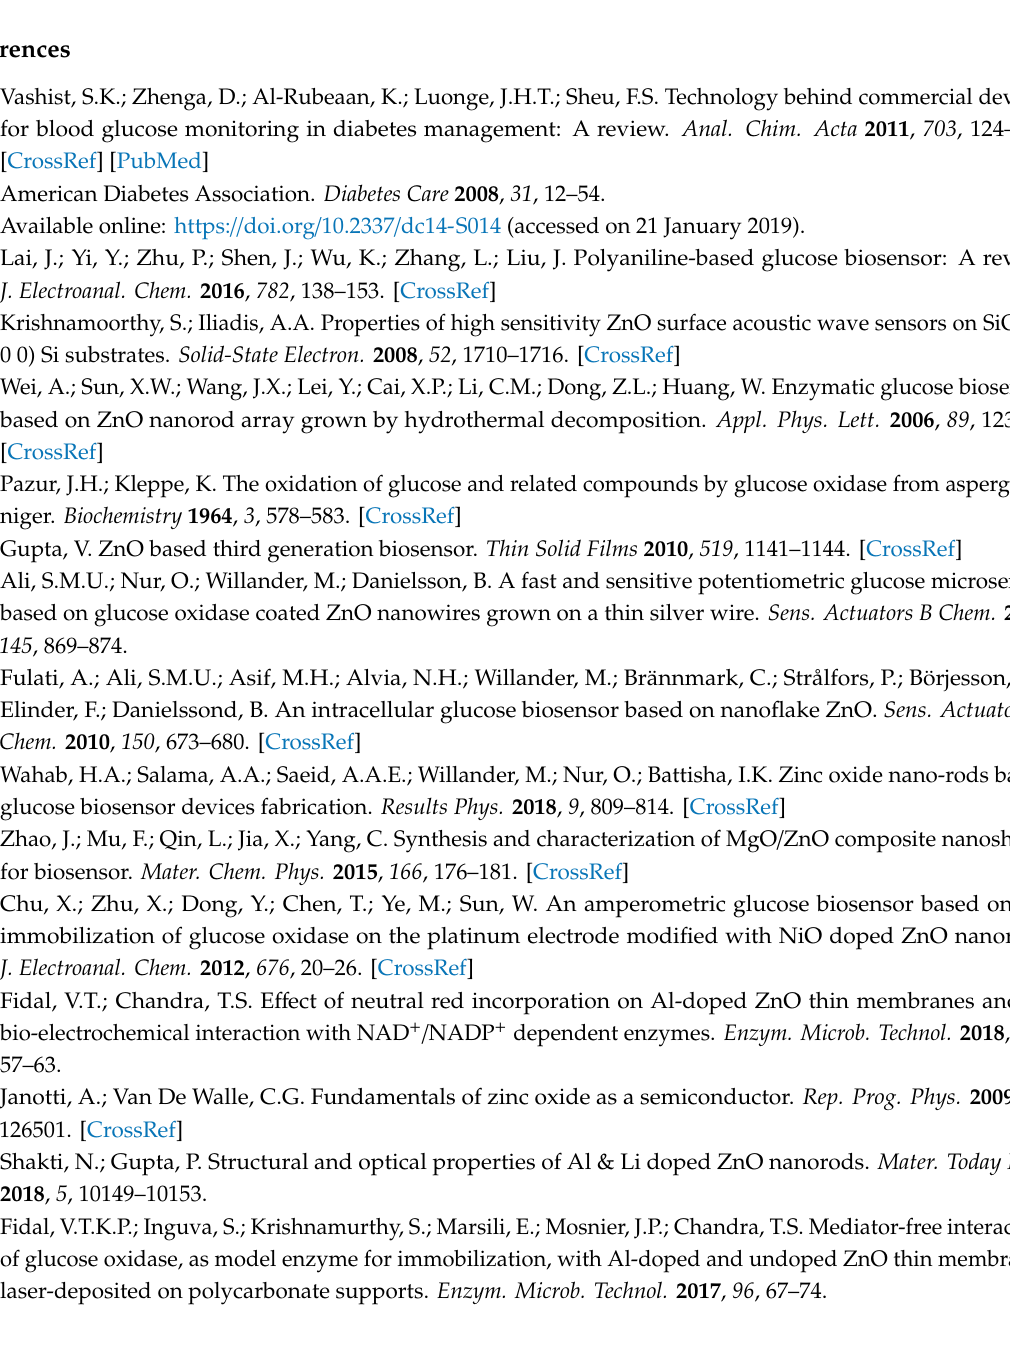
Figure S1: EDX spectra of di ff erent membranes: (a) ZnO and (b) AZO, Figure S2: The reducibility test for the lifetime of the glucose biosensors, Table S1: p -value for response voltages intervals under di ff erent glucose